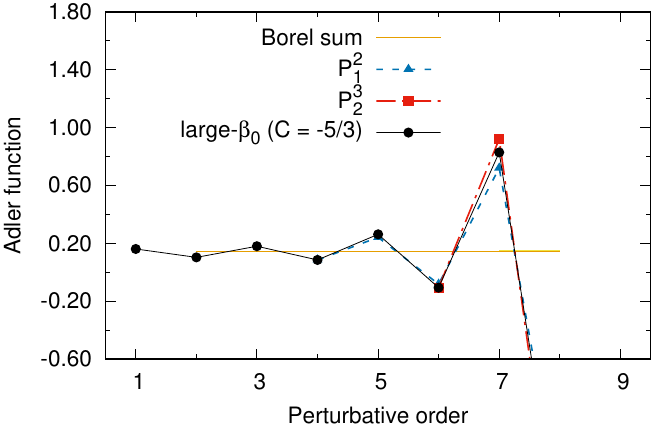
Figure 4. Perturbative expansion of the Adler function in large- (cid:12) 0 in a scheme with C = (cid:0) 5 = 3 (solid line) and using the P 2 ( u ) (dashed line) and P 3 ( u ) (dot dashed line). The scheme-invariant 1 2 result for the Borel sum of the series is the same as in (cid:12)gure 1. The value of the strong coupling in this scheme is ^ (cid:11) s ( m (cid:28) ) = 0 : 5074 (see